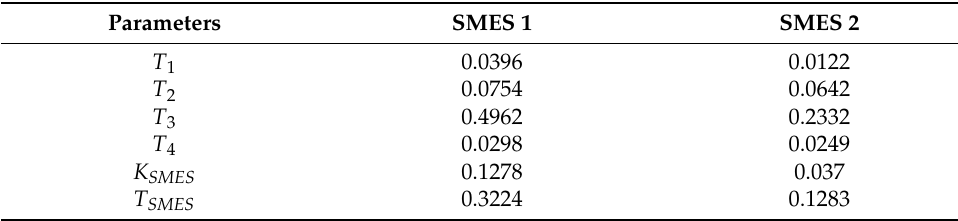
Table 13. SMES-optimized parameters for SMES-GCSE-SMES coordination.